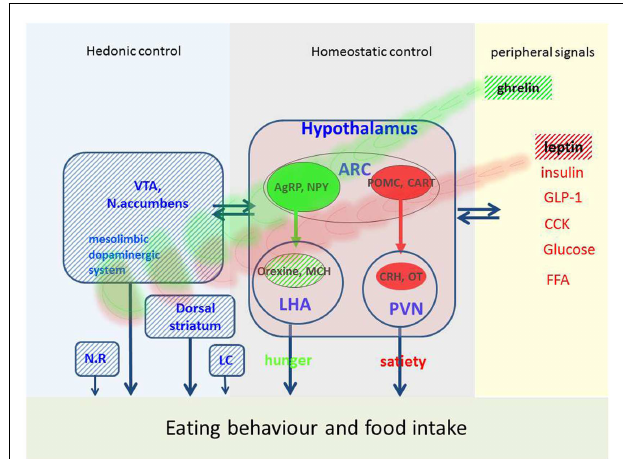
FIGURE 1 | Possible factors implicated in eating behavior and food intake in PD . Eating behavior is regulated by hedonic, homeostatic, and peripheral signals.This figure represents the main mechanisms, which are disturbed in PD (hatched areas) and may affect eating behavior.VTA, ventral-tegmental area; ARC, arcuate nucleus; NR, nucleus raphe; LC, locus coeruleus; PVN, paraventricular nucleus; LHA, lateral hypothalamus; AgRP, agouti-gene related peptide; NPY, neuropeptideY; MCH, melanin-concentration hormone; POMC, proopiomelanocortin; CART, cocaine-and-amphetamine-regulated transcript; CRH, corticotropin-releasing hormone; OT, oxytocin; GLP-1, glucagon-like peptide; CCK, cholecystokinin; FFA, free fatty